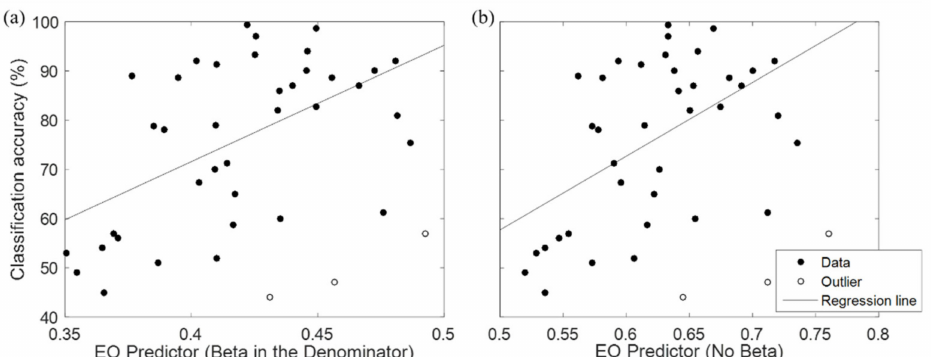
Figure 5. ( a ) Regression analysis between the modified PP factor (Case 2, beta power in the denominator) and online BCI classification accuracy, and ( b ) Regression analysis between the modified PP factor (Case 3, no beta power) and online BCI classification accuracy. Outliers (90% confidence interval) are shown as blank